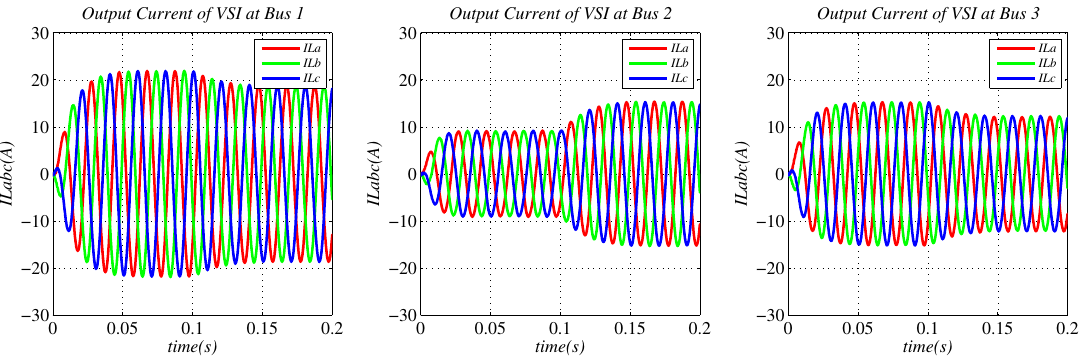
Figure 4. Output voltages of the VSI at Buses 1, 2, and 3 in the abc reference frame.